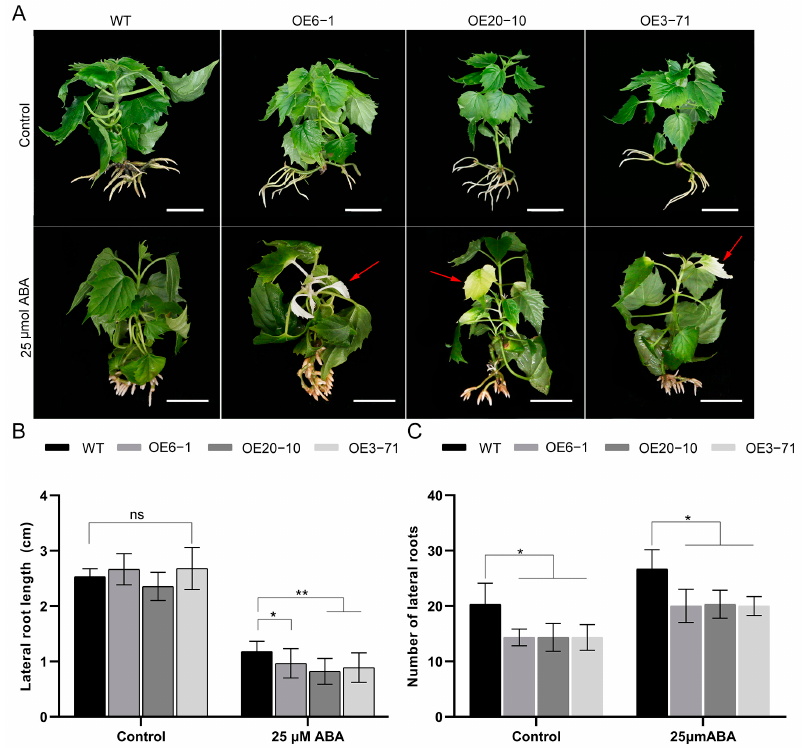
Figure 5. Overexpression of CbWRKY27 enhances ABA sensitivity in transgenic plants. ( A ) Phenotype of OE lines and WT treated with 25 or 0 μ mol ABA. ( B ) Length of lateral roots and ( C ) Number of lateral roots before and after ABA treatment. Bar = 2cm. The red arrow points to the whitened part of the leafThe data represent the means ± SD ( n = 3), * p < 0.05 and ** p < 0.01 using Student’s t - test.